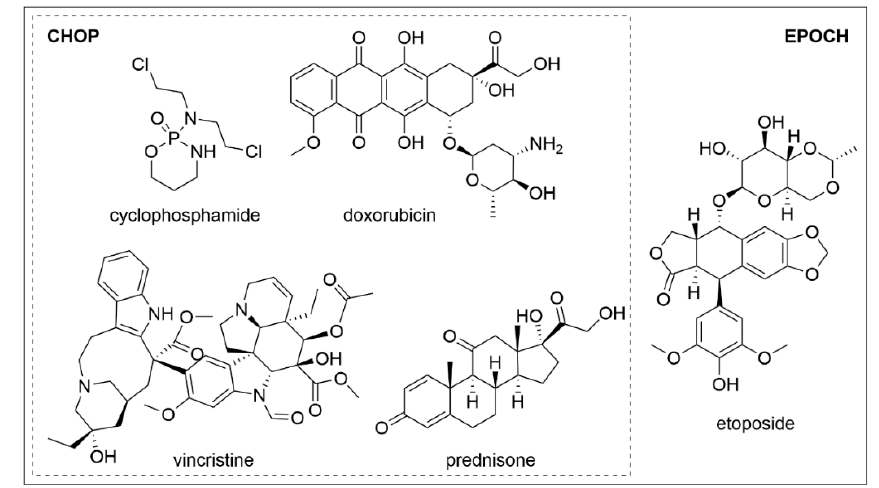
Figure 3. Chemical structures of cyclophosphamide, doxorubicin, vincristine, and prednisone (together forming the CHOP regimen) and etoposide (with CHOP forming the EPOCH regimen). Currently, CHOP is used more often in combination with rituximab (R-CHOP). Table 1. Ongoing (not yet recruiting; recruiting; enrolling by invitation; active, not recruiting) clinical trials with low- molecular-weight compounds combined with cyclophosphamide, doxorubicin, vincristine, and prednisone (May 2021).